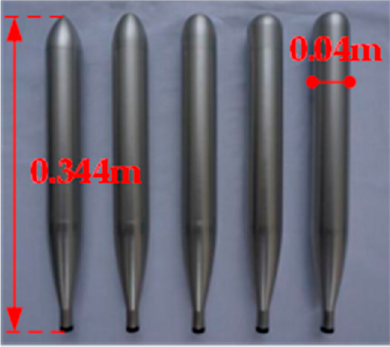
Figure 4. Model physical map.